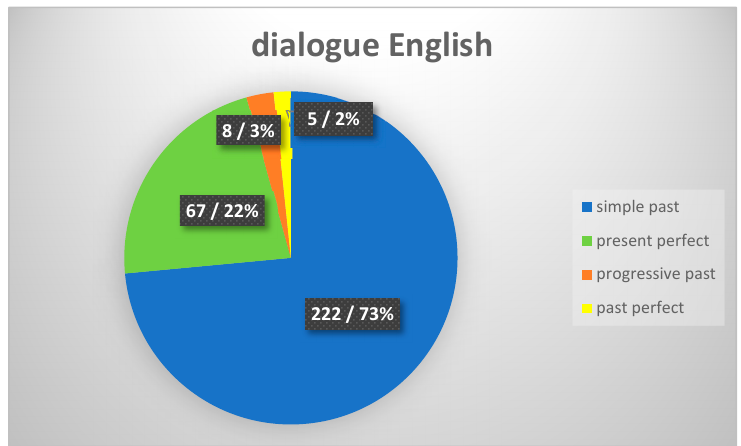
Figure 3. Distribution of English past forms in corpus B (dialogue with weak narration).